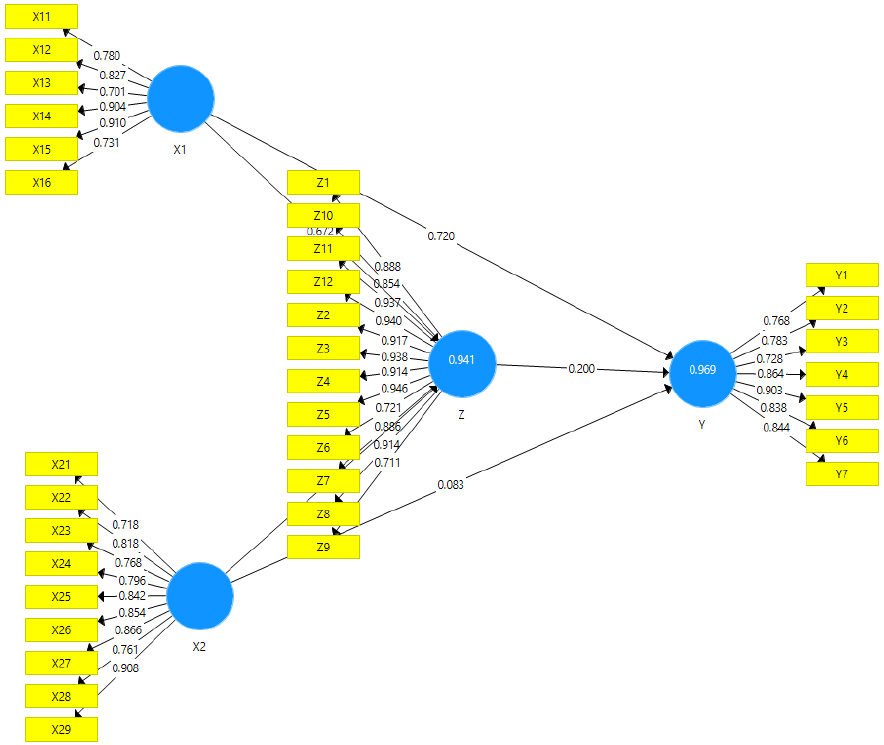
Figure 2: Direct Effect Test Results ; Source : Processed Primary Data